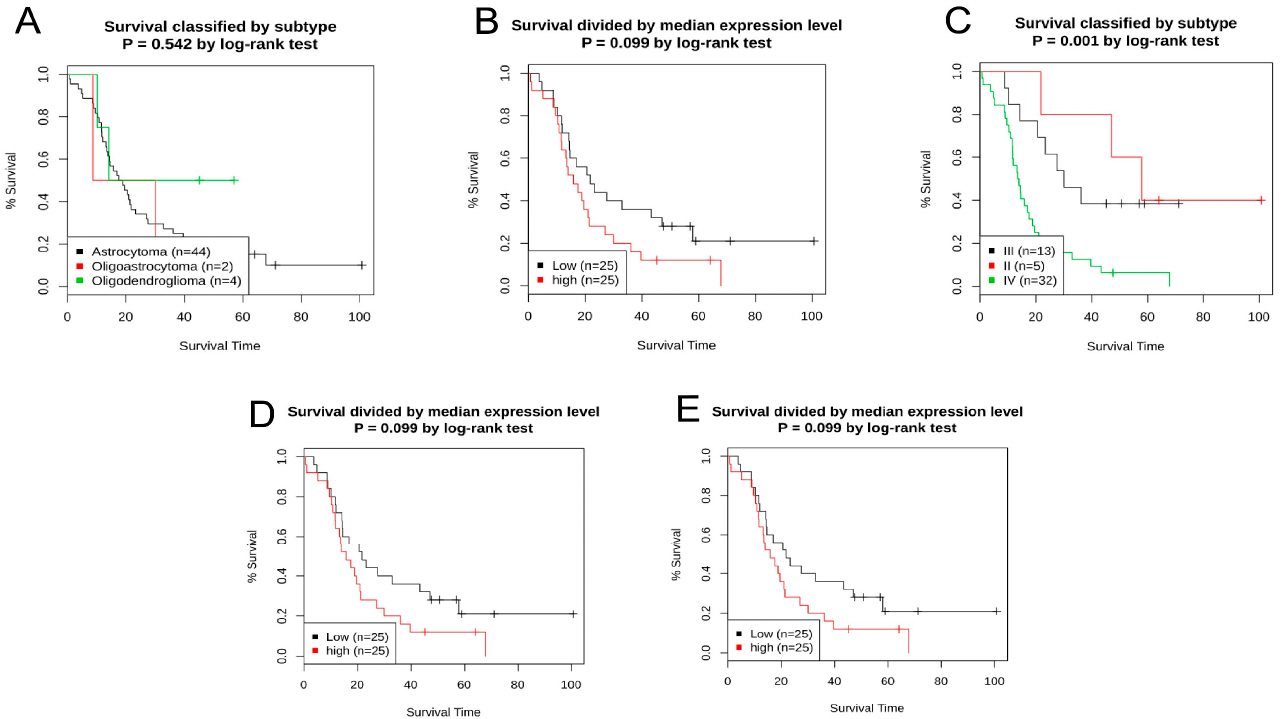
Figure 7. Prognostic significance of the MDM2 gene in human brain lower-grade glioma (LGG) cancer as determined by the GENT2 server. ( A ) Overall survival for the disease stage was determined by dividing KM plots by the median cutoff. ( B ) Overall survival for the disease stage was determined by dividing the KM plots by the median cutoff. ( C ) Overall survival grade in KM plots was divided by subgroups. ( D ) Survival (overall) for grades KM plots separated via median value. ( E ) Survival (overall) for histology is determined for adding KM plots by the median cutoff.